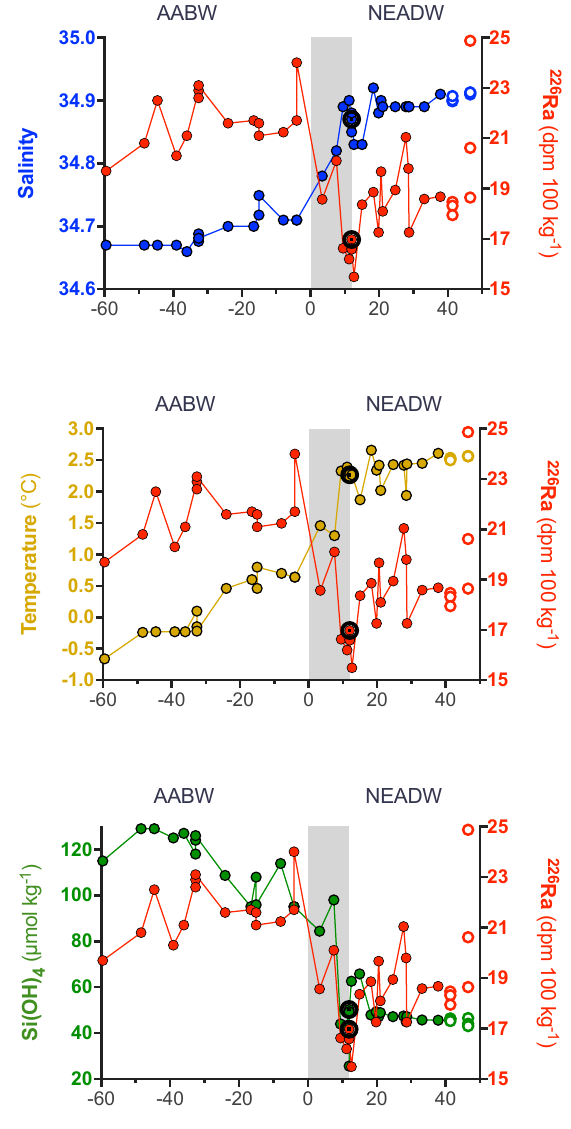
Figure 8. Geographical variation in 226 Ra activities (red dots), salinity (blue dots), temperature (yellow dots) and Si(OH) 4 concen- trations (green dots) in AABW and the NEADWl between 60 ◦ S and 45 ◦ N (GA01 section) in the Atlantic Ocean based on data from the GEOSECS and TTO programs. The 226 Ra activities, salin- ity, temperature and Si(OH) 4 concentrations from GA01 are repre- sented by open circles. The values used as end-members for the OMP analysis are also identified by the black circles. The shaded area represents the region in which transformation of the AABW into NEADWl takes